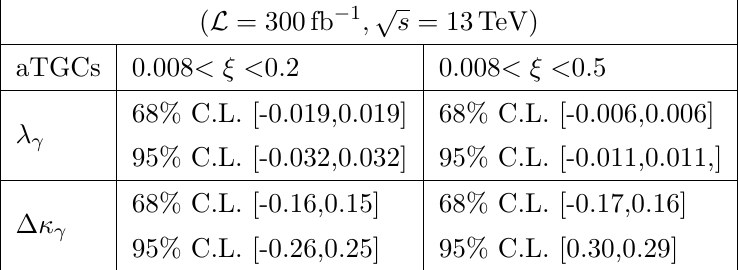
Table 6 . 68% and 95% C.L expected limit on the (cid:21) (cid:13) and (cid:1) k (cid:13) couplings assuming two di(cid:11)erent acceptances, 0.008 < (cid:24) < 0.2 and 0.008 < (cid:24) < 0.5, considering the IL corresponds to 300 fb (cid:0) 1 .